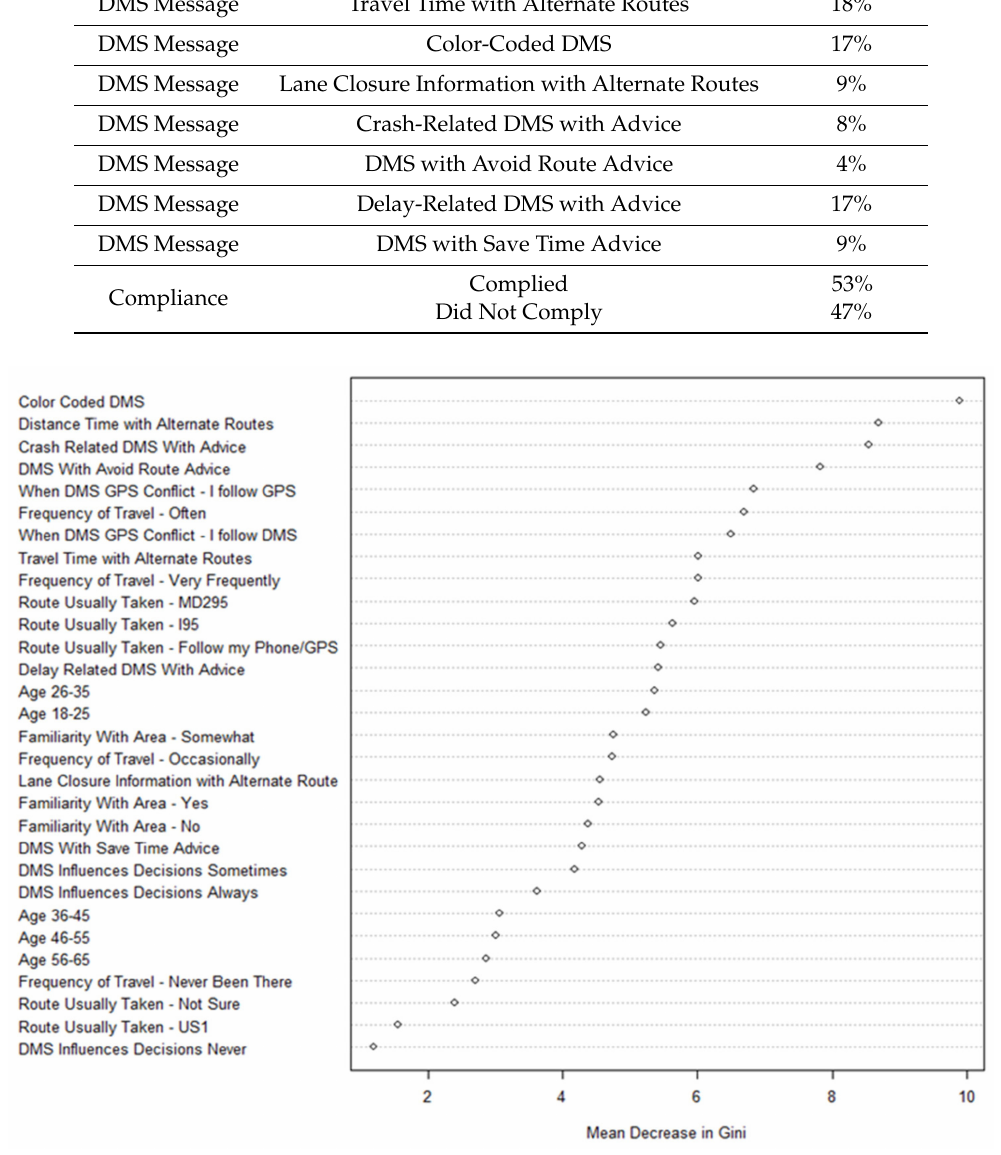
Figure 11. Plot of variable importance for compliance by MDG